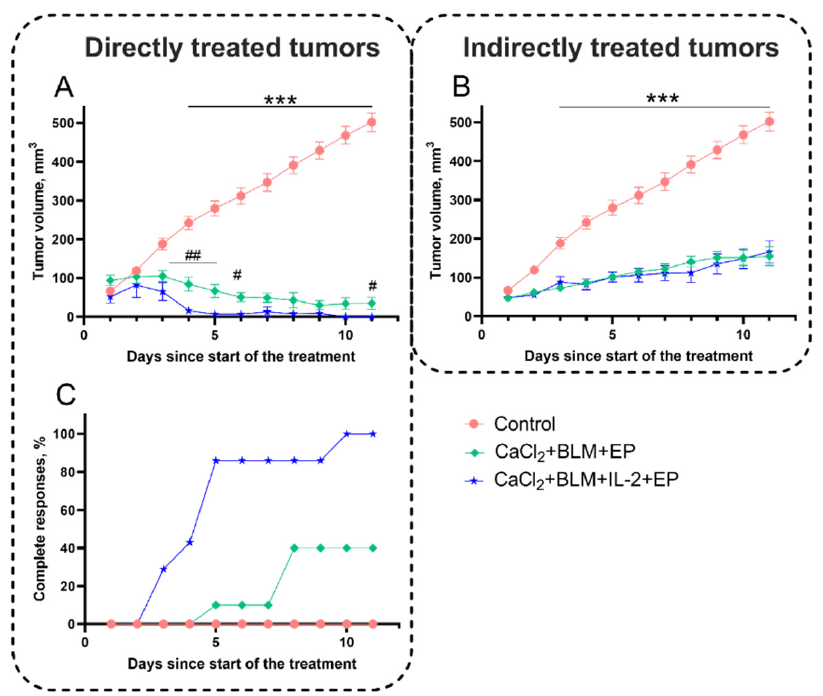
Figure 9. Tumor growth changes and number of complete responses after different electroporation-based therapies. Tumor growth changes in directly ( A ) and indirectly ( B ) treated tumors using combination of calcium electroporation and bleomycin electrotransfer without or with IL-2 transfection. ( C ) Percentage of directly treated tumors with complete response. Eight 1500 V/cm, 100 µ s duration pulses were used for tumor electroporation. Bleomycin solution (200 µ L, 470 µ M) was injected i.v. while CaCl 2 solution (half of the tumor volume, 168 mM) was injected i.t. For muscle transfection, both tibialis anterior muscles were injected with IL-2 coding plasmid solution (1 mg/mL) and electroporated 10 min later using eight 200 V/cm, 20 ms duration pulses. At least 8 mice with two tumors each were treated for every experiment point. Statistical significance of differences between experimental groups was evaluated using t -test. The *** symbols represent statistical significance of p < 0.001 between control (no treatment) and individual experimental groups. # and ## symbols represent statistical difference of p < 0.05 and p < 0.01, between Ca + BLM + EP and Ca + BLM + EP + IL-2 groups.